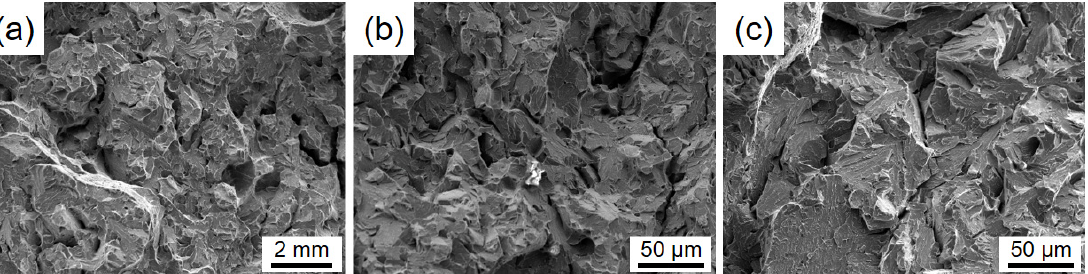
Figure 9. Micro-morphology of fracture surface of three experimental samples impact tested at − 120 °C: ( a ) Q850, ( b ) Q950 and ( c ) Q1050.